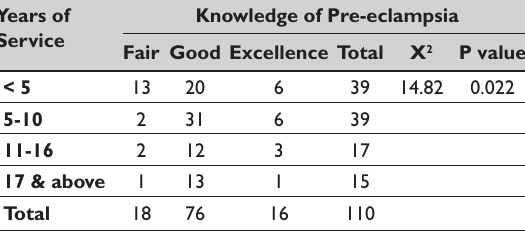
Table 7: Association between Respondent’s Level of Knowledge and Years of Service Years of